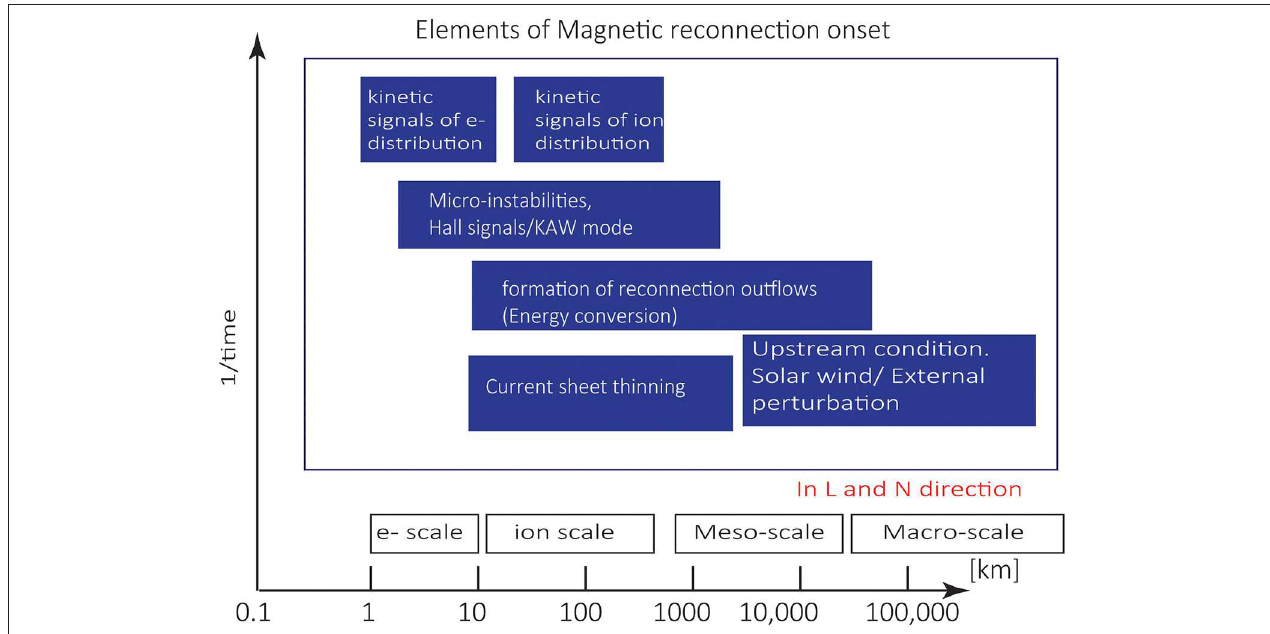
FIGURE 3 | Science questions of AME mission. Schematic of the scales of physical processes in the reconnection onset problem. This includes but not limited to upstream conditions, solar wind/external perturbation, current sheet thinning, reconnection outflows, Kinetic Alfven Waves (KAW)/Hall signals, micro-instabilities, kinetic signals of electron/ion distributions.